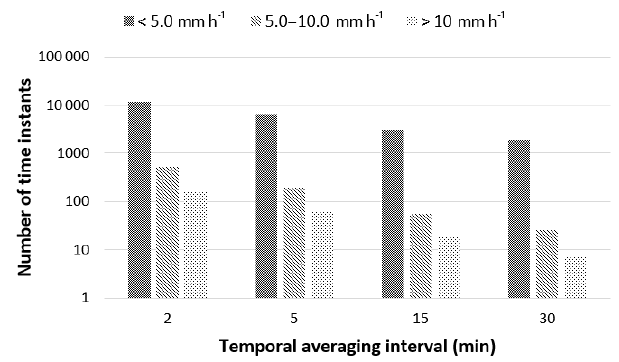
Figure 5. Number of time instants for each temporal averaging in- terval and rainfall intensity class